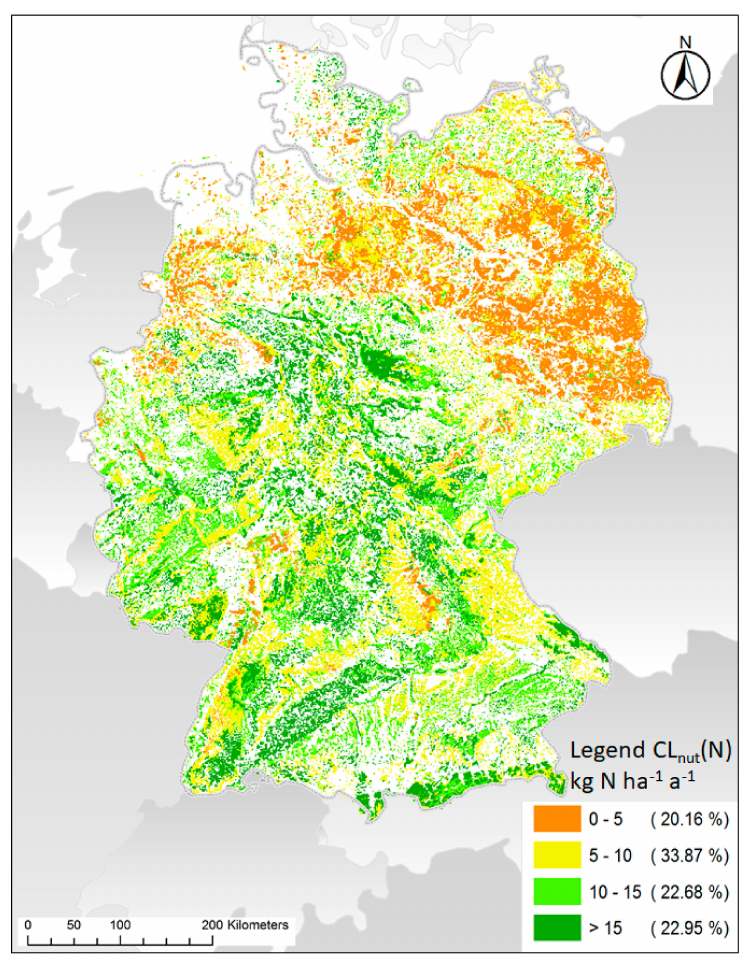
Figure 4. Critical loads for eutrophying nitrogen inputs, created by the